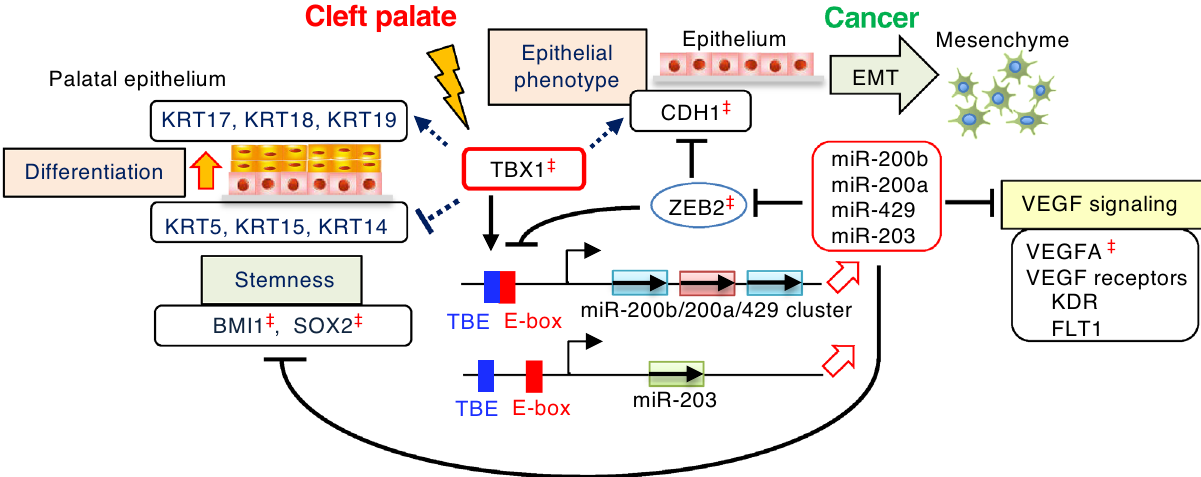
Figure 6. Proposed model of TBX1-mediated regulation of stemness and differentiation in epithelial cells through the miR-200–ZEB2 axis. ZEB2 and miR-200 reciprocally repress each other’s expression and are linked in a double-negative feedback loop 12,13,15 . TBX1 rescues ZEB2-dependent inhibition of the miR-200b- 200a-429 promoter and induces the expression of miR-200, which controls the expression of EMT- and VEGFA-related molecules. In addition, TBX1 induces miR-203 expression, which, together with miR-200, inhibits the expression of stem cell factors. In conclusion, TBX1 links the maintenance of stemness and epithelial differentiation, pathologically in epithelial cervical cancer, and physiologically in palatal development. ‡ , molecules associated with cleft palate in humans and/or